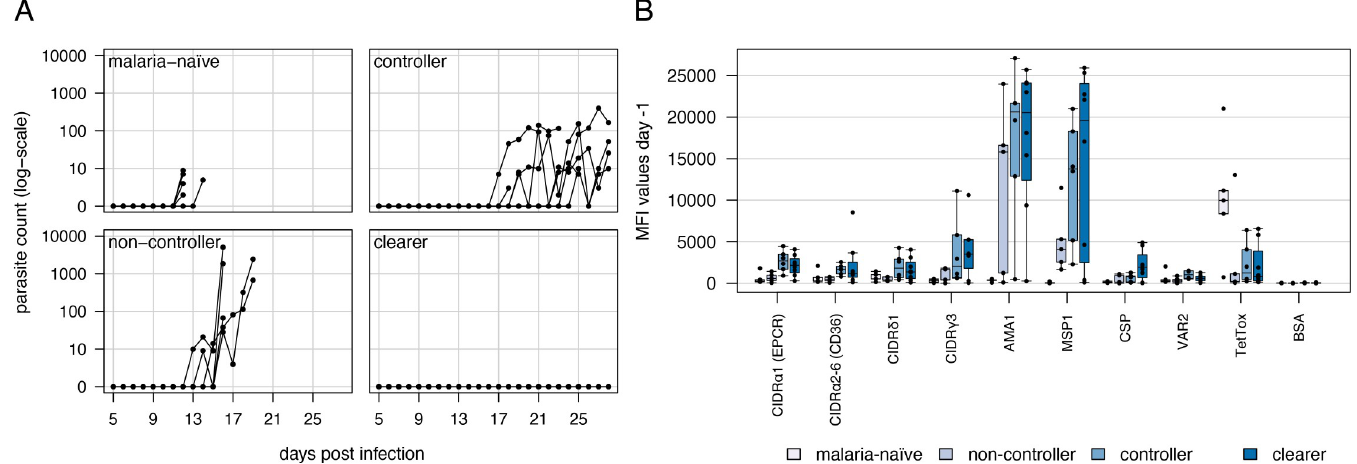
Fig 1. Subgrouping of volunteers into malaria-na ï ve, ‘non-controller’, ‘controller’ and ‘clearer’. (A) Parasite counts determined by thick blood smear. Parasite counts (parasites/ μ l) during the course of the CHMI trial determined by thick blood smear until treatment was initiated. Parasite replication occurs exponentially in malaria- na ï ve controls (n = 5), which were treated immediately after first detection of parasites in the peripheral blood. Lifelong malaria-exposed volunteers were grouped according to their ability to control parasite growth. ‘Non-controller’ (n = 6) showed a delayed exponential parasite replication, ‘controller’ (n = 6) were able to control the parasitemia below 100 parasites/ μ l and ‘clearer’ (n = 8) were able to eliminate injected parasites and thick blood smears were never positive for parasites. (B) Reactivity of volunteer sera with Pf EMP1-specific antigens and control proteins at the start of the trial. The reactivity of sera from the different volunteer groups to EPCR-binding CIDR α 1 domains (n = 19), CD36-binding CIDR α 2–6 domains (n = 12) and CIDR domains with unknown binding phenotype (CIDR γ 3: n = 1, CIDR δ 1: n = 3) was assessed by luminex assay. The P . falciparum antigens AMA1, MSP1, CSP known to induce an antibody response in humans served as positive controls. Furthermore, beads coated with VAR2CSA (VAR2), tetanus toxin (TetTox) and bovine serum albumin (BSA) were used as additional controls. Individual mean fluorescence intensities (MFI) are shown in a box plot extending from the 25 th to the 75 th percentiles with a line at the median. Number of sera analyzed from the different volunteer groups were ‘malaria-na ï ve’ n = 5, ‘non-controller’ n = 5, ‘controller’ n = 6 and ‘clearer’ n =